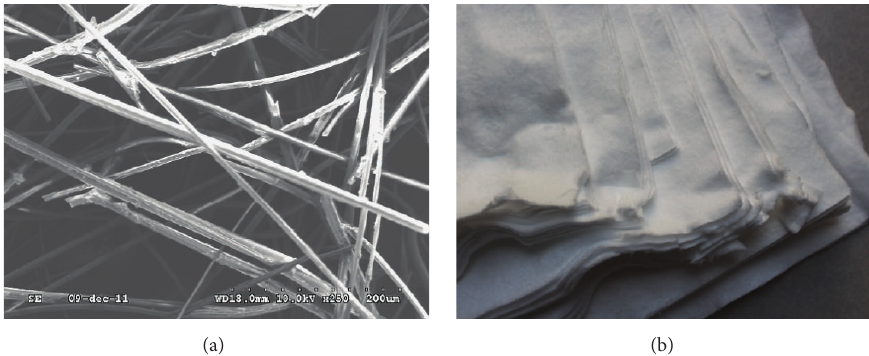
Figure 2: Scanning electron image (a) [13] and real image (b) (taken by authors) of glass fibers. Left image is a SEM picture of glass fiber insulation. The shape of the glass fibers is cylindrical which lead to small areas of contacts and thus small conductive heat transfer even if the material is compressed [13].